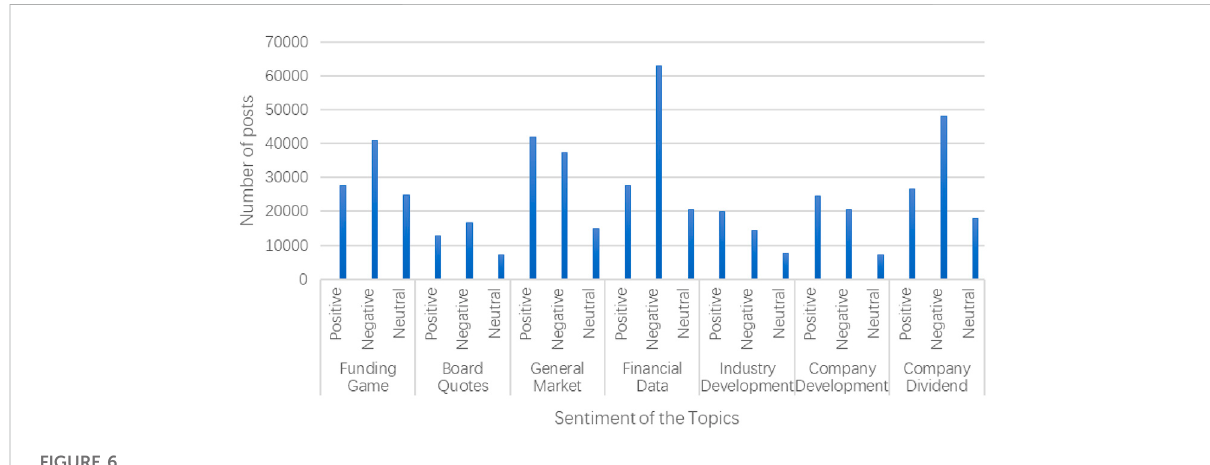
FIGURE 6 Sentiment analysis results of all